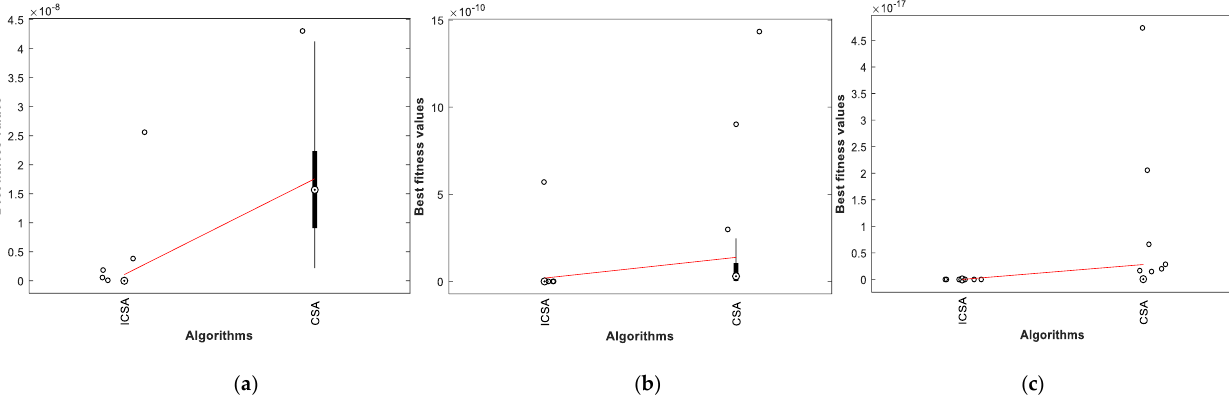
Figure 30. Boxplot of CSA and ICSA for various test cases : ( a ) Boxplot for F13; ( b ) Boxplot for F14; ( c ) Boxplot for F7.